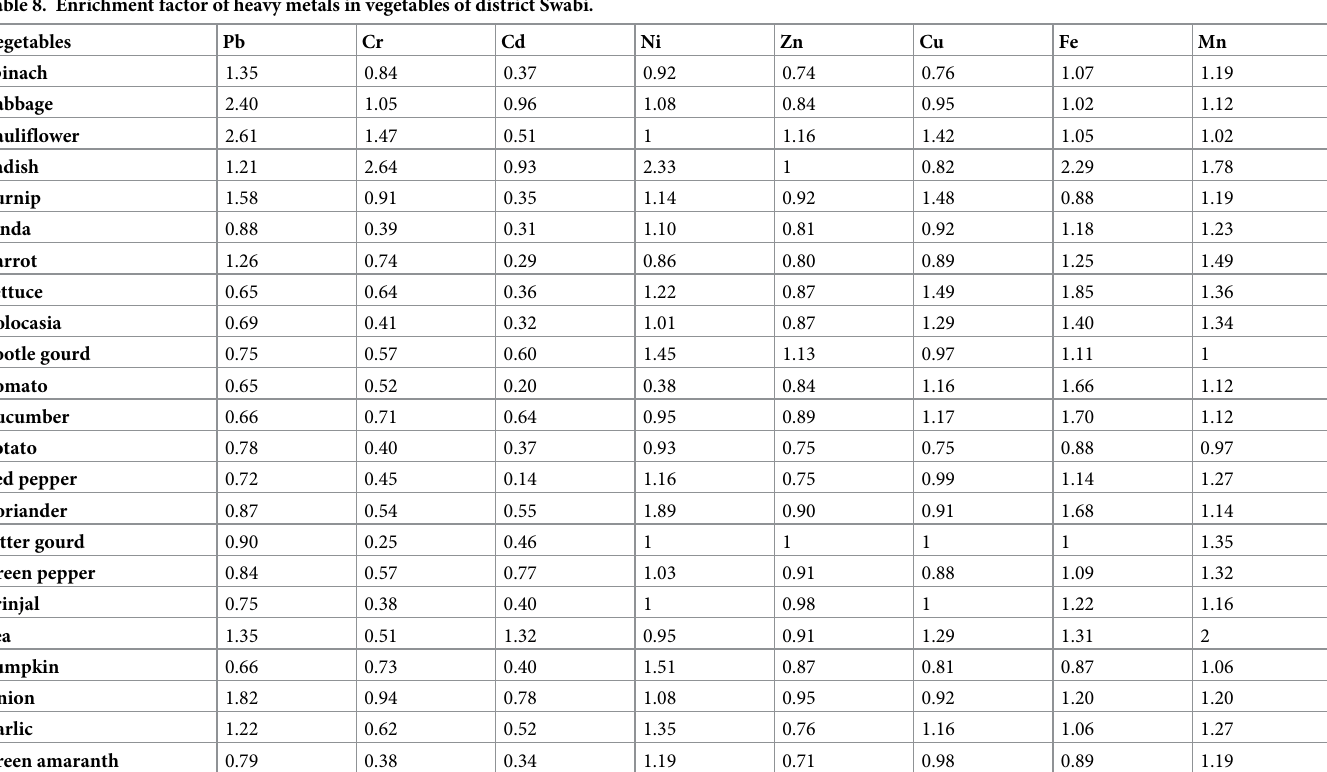
Table 8. Enrichment factor of heavy metals in vegetables of district